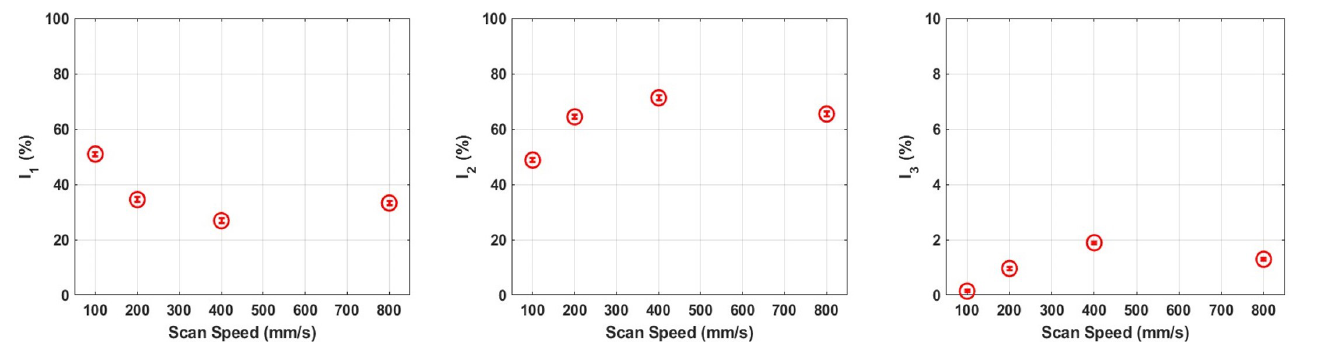
Figure 8. Constrained fitting for LPBF molybdenum. The I 1 , I 2 , and I 3 correspond to the three fixed lifetime components: 115, 135, and 430 ps,